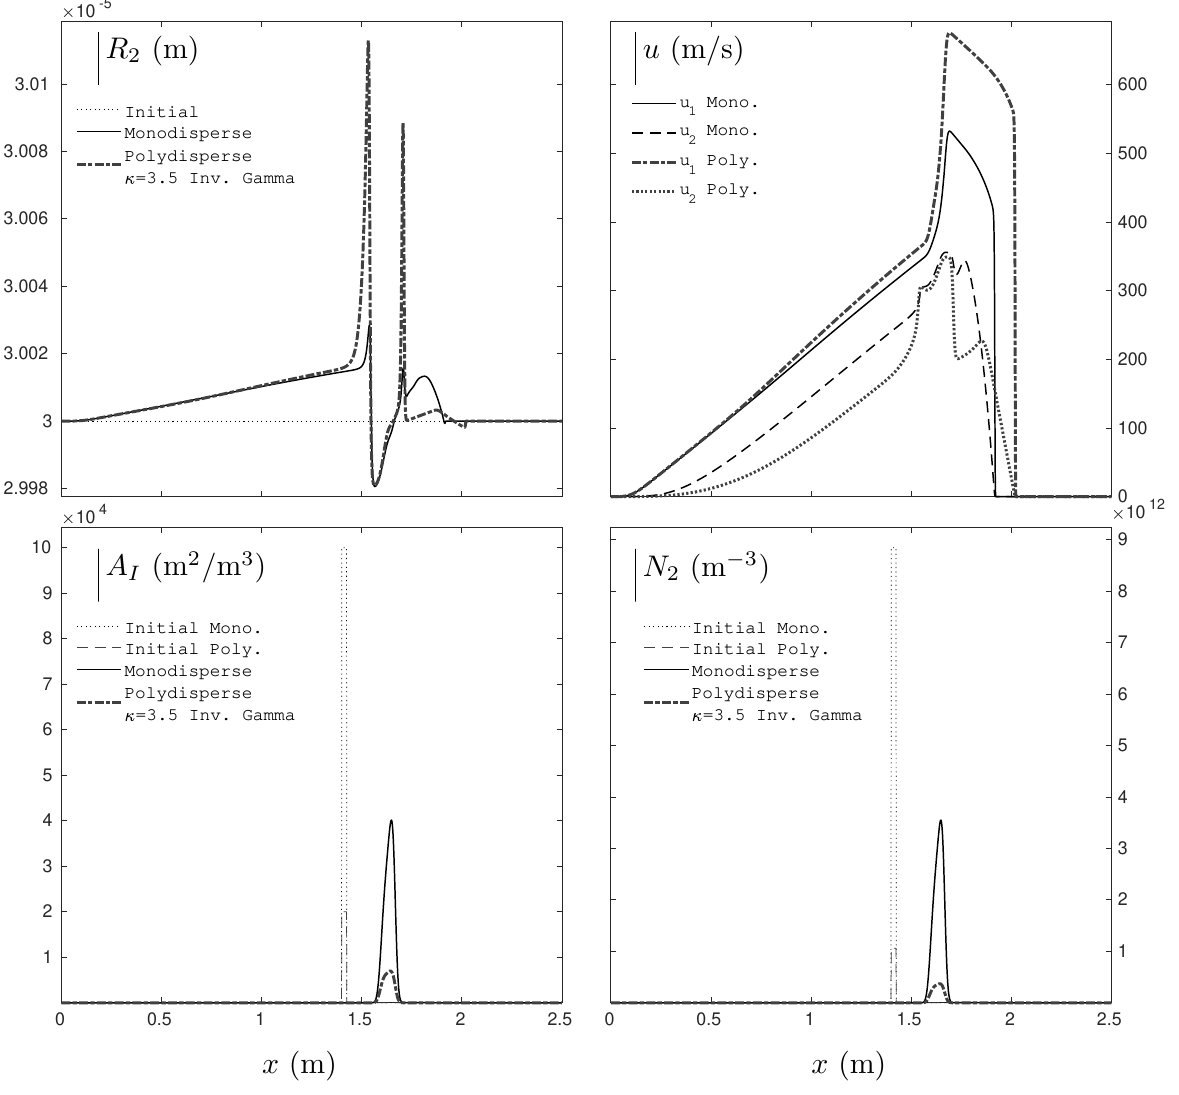
Figure 19: Simplified two-phase explosion test depicted in Fig. 5. Comparison of the monosdisperse and polydisperse results. Figure 19. Simplified two-phase explosion test depicted in Figure 5. Comparison of the monodisperse t =0 = 30 µ m. For the polydisperse computation, the = R t =0 The initial mean radius is the same for both computations R 2 t = 0 = R t = 0 2 = and polydisperse results. The initial mean radius is the same for both computations R 2 2 Inverse Gamma distribution is used with κ = 3 . 5. All results are given at time t = 1 . 2 ms and are presented in terms of A I , u , 30 µ m. For the polydisperse computation, the Inverse Gamma distribution is used with κ = 3.5. N 2 and R 2 for both computations. Differences between the two solutions are visible. All results are given at time t = 1.2 ms and are presented in terms of A I , u , N 2 and R 2 for both computations. Differences between the two solutions are